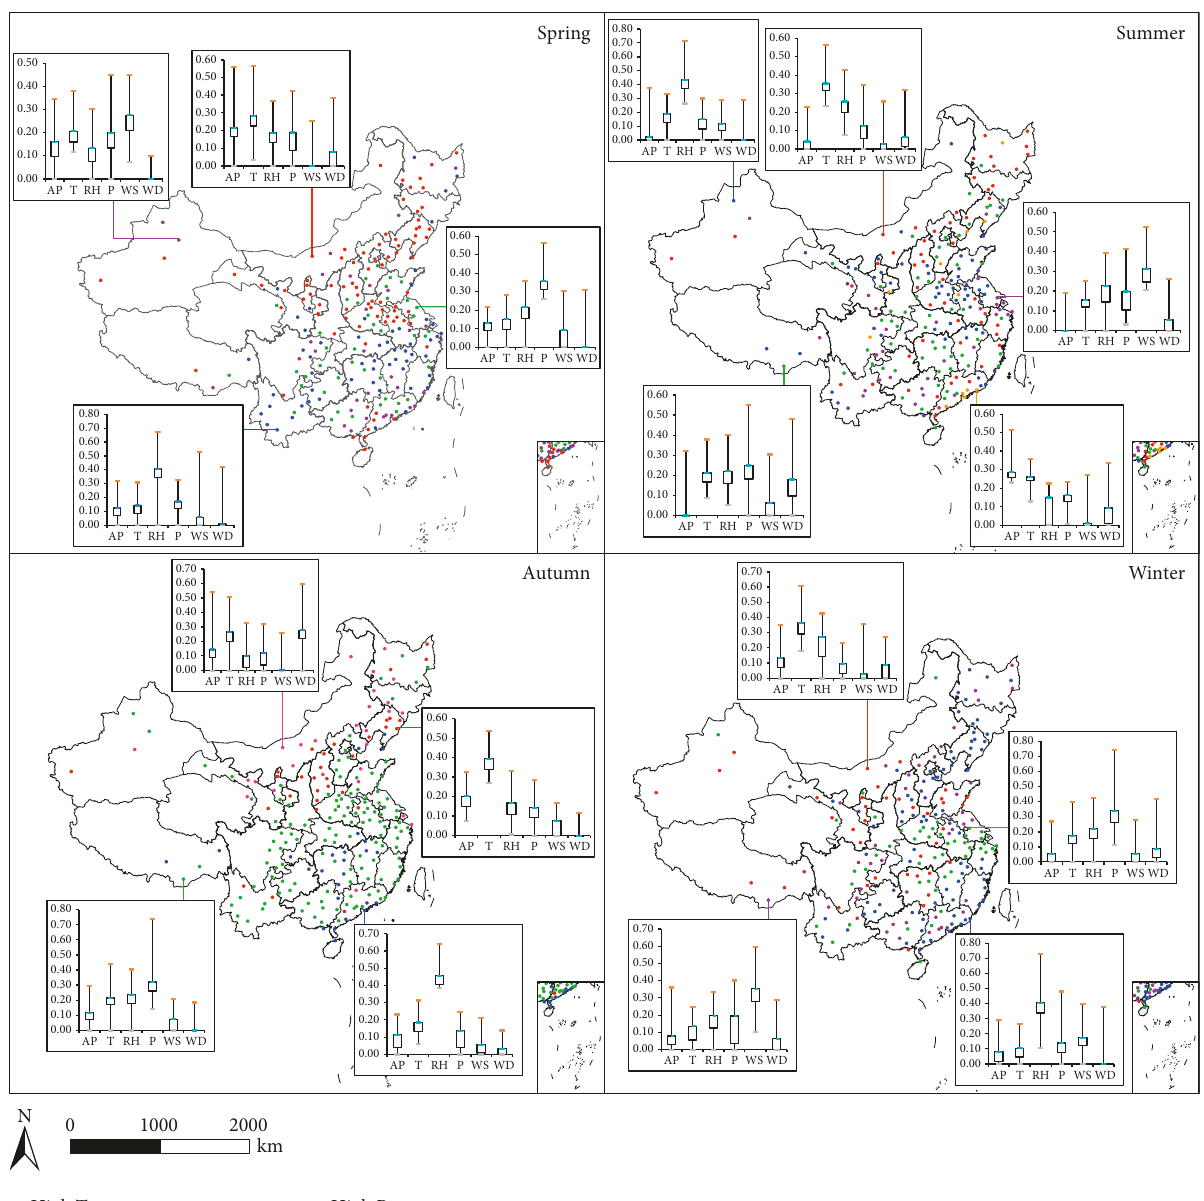
Figure 11: Relationship between PM 10 concentration and meteorological